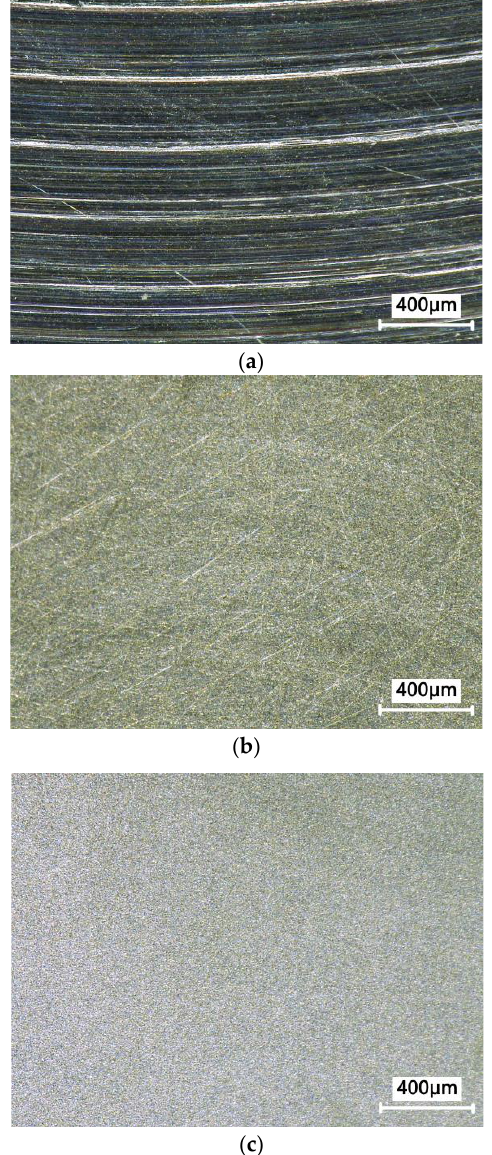
Figure 12. Surface micrograph: ( a ) after milling, ( b ) after MAF, ( c ) after UAMAF.